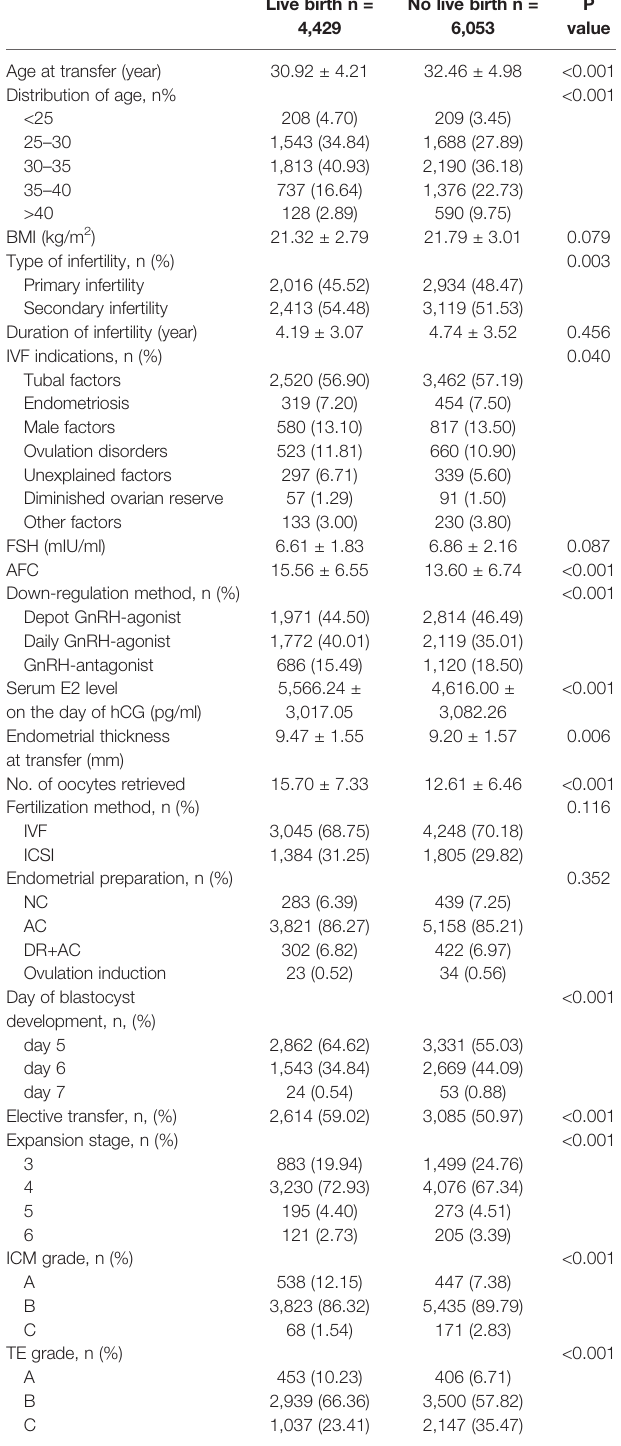
TABLE 1 | Demographic and clinical features according to the live